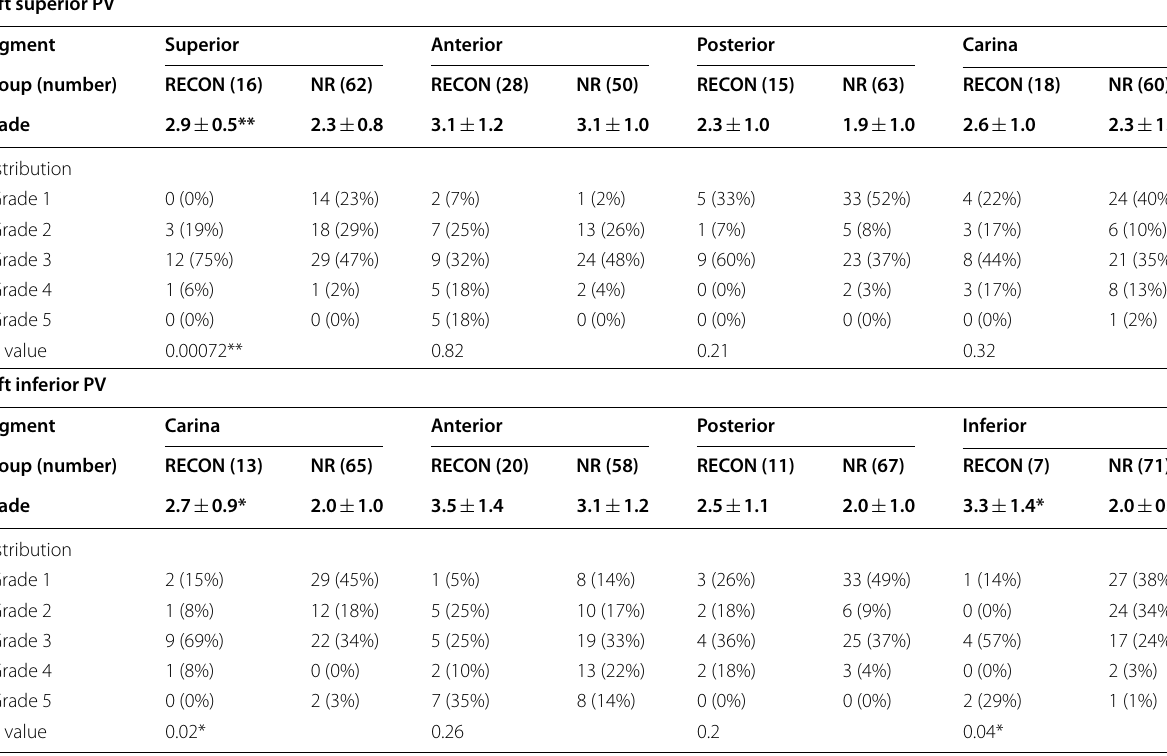
Table 4 Wall thickness of left PV